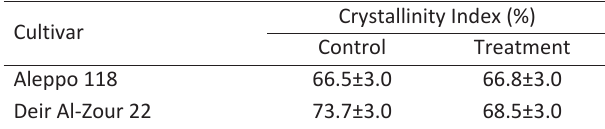
Table 3 - Fiber crystalline index in control and treated Aleppo